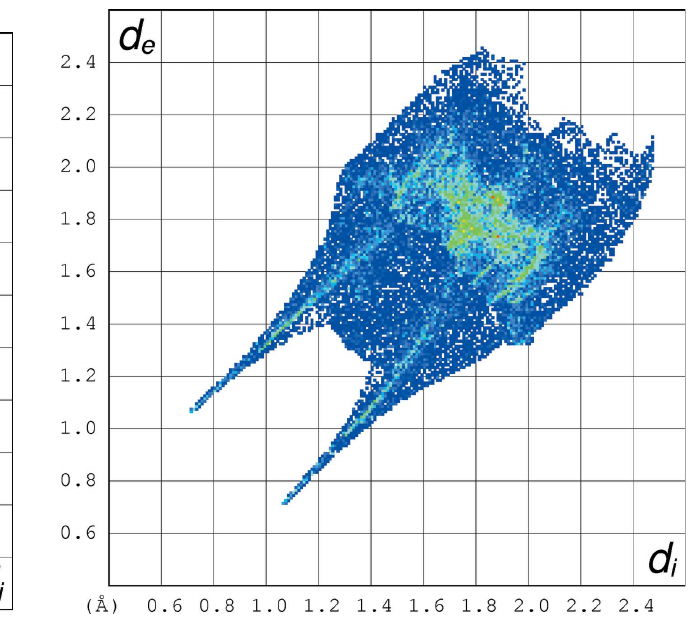
Figure 7 Hirshfeld fingerprint plot for tioxolone [atomic coordinates from Byres & Cox (2004)].